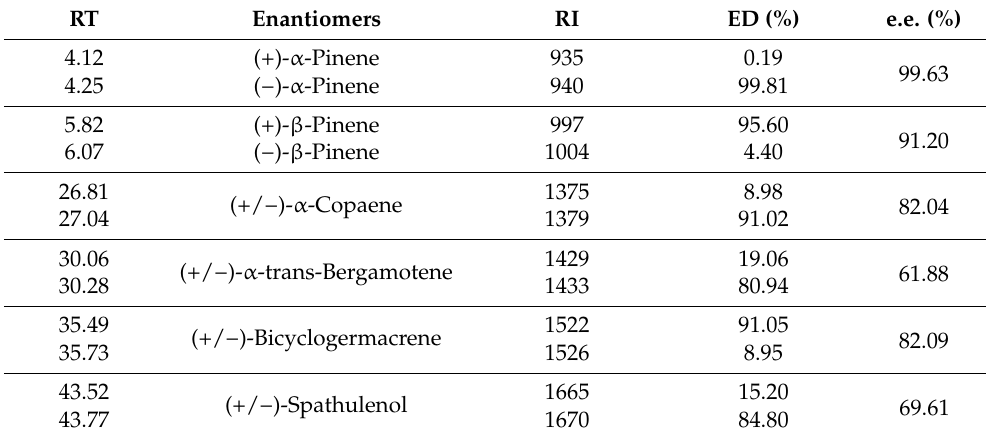
Table 3. Chiral compounds present in the essential oil of the leaves from Bixa orellana .